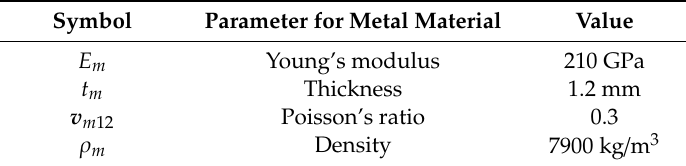
Table 2. Material parameters of metal on the outermost layer.